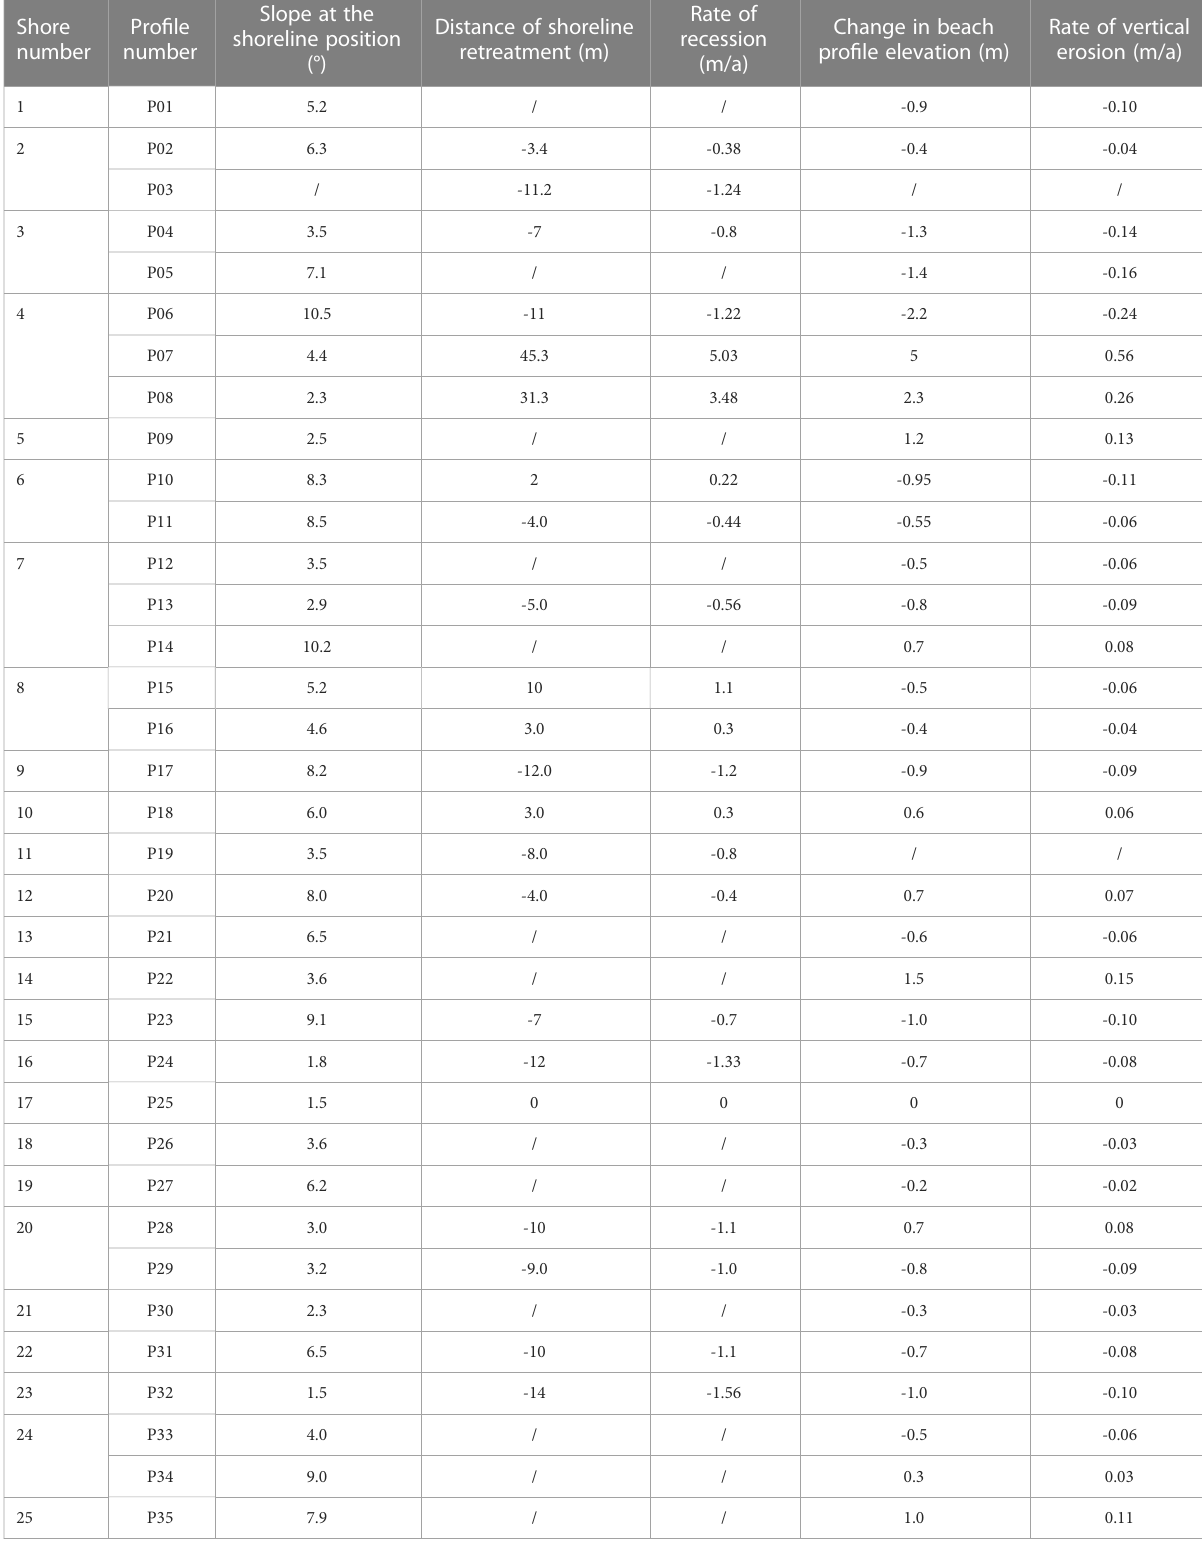
TABLE 2 Erosion of sandy shores on the Shandong